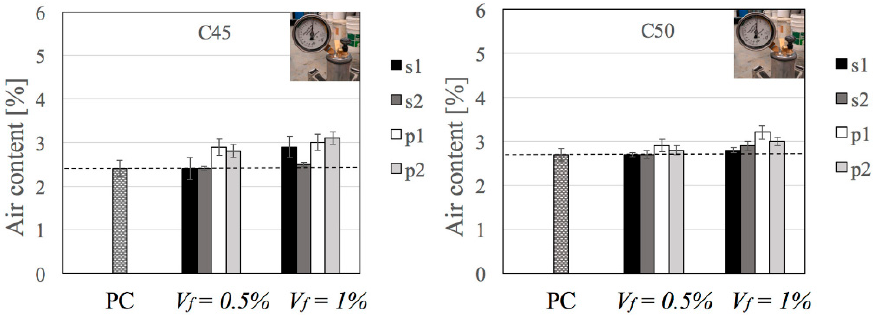
Figure 2. Air content measurement of plain concrete (PC) and fiber reinforced concretes for V f = 0.5% and V f = 1%.